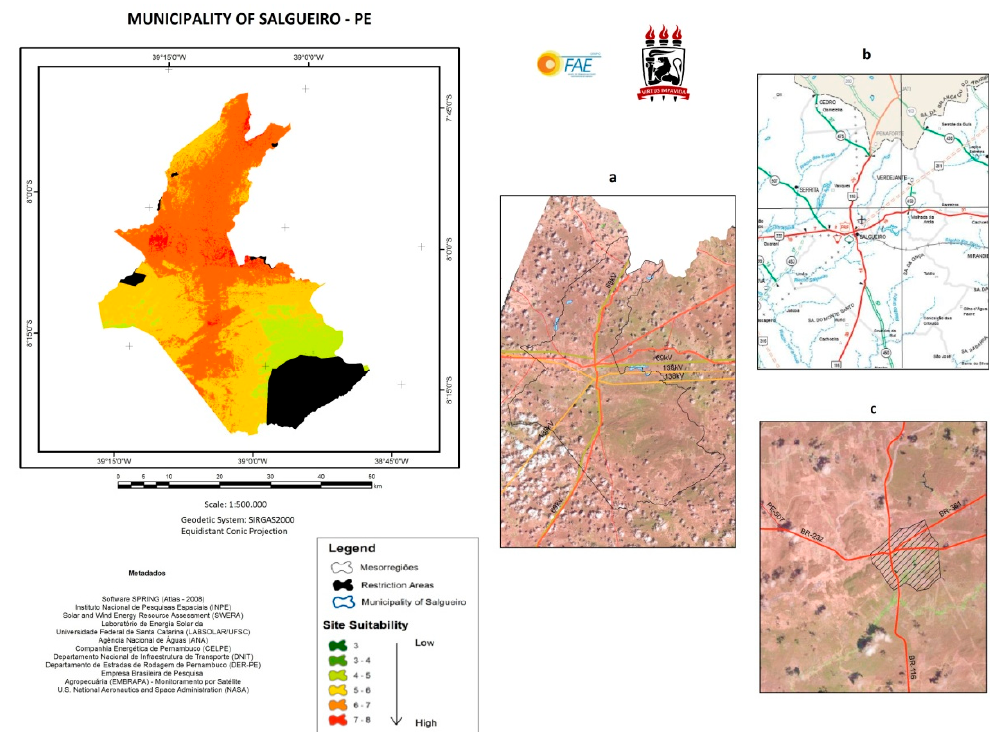
Figure 16. Municipality of Salgueiro in LANDSAT8 images: ( a ) the spatial position of the municipality of Salgueiro; ( b ) multimodal map of the State of the Pernambuco; and ( c ) the spatial position of the urban area of Salgueiro.